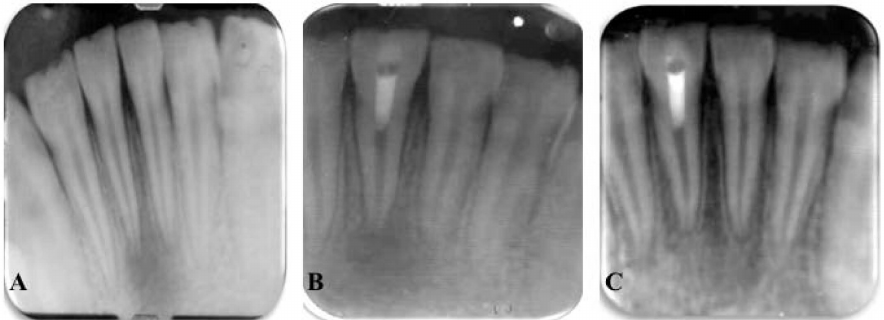
Figure 3. Radiographs of revascularized human mature teeth #25. ( A ) Preoperative radiograph to show inflammatory periapical lesion; ( B ) Postoperative radiograph after regenerative endodontic procedures; ( C ) At 12-month follow-up, resolution of apical periodontitis